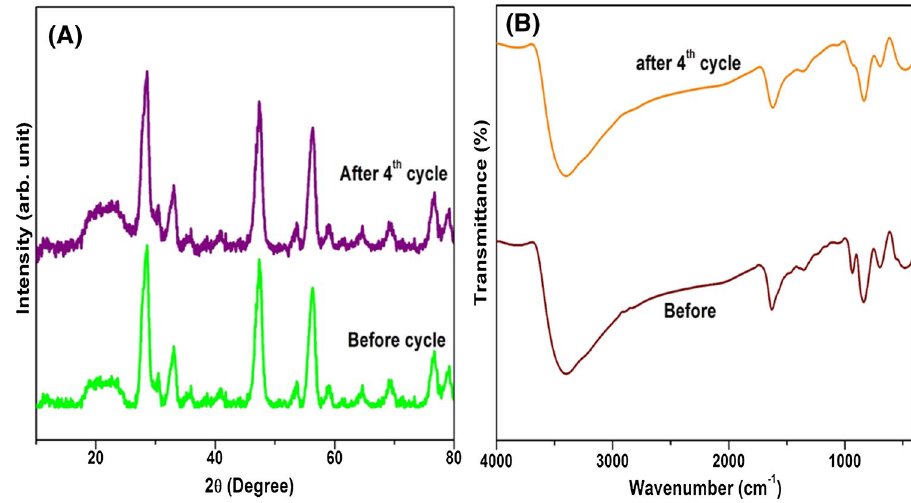
Fig. 10 a XRD pattern b